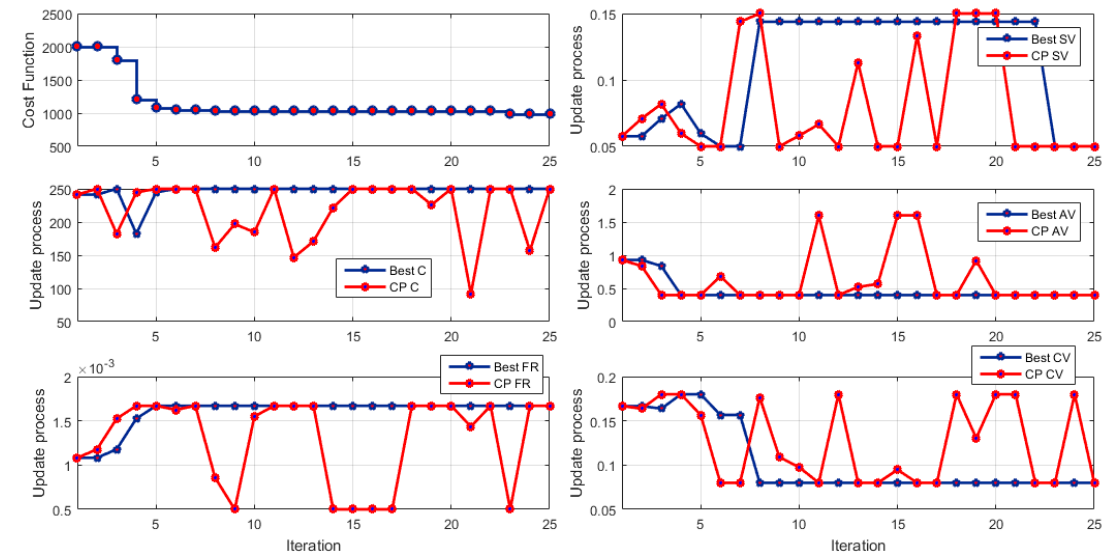
Figure 9. The cost function variation, best values of decision variables during the multi-objective optimization process. C is the capacitance, CP is the center point, FR is the flow rate, SV is the spacer volume, AV is the applied voltage, and CV is the cell volume.